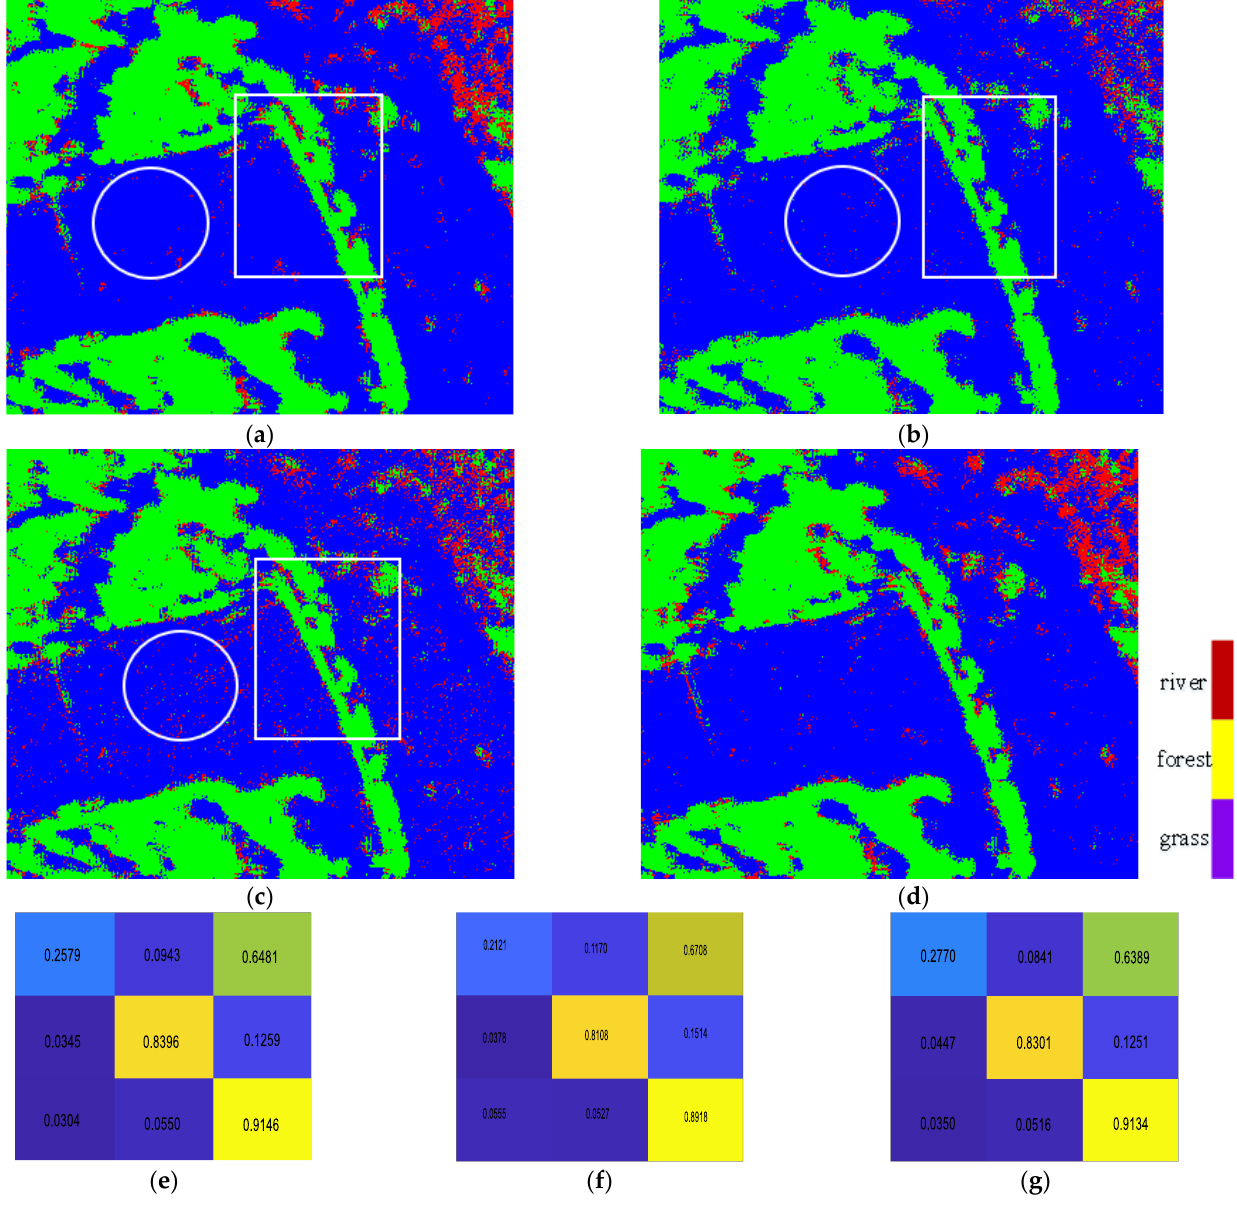
Figure 16. The classification results on TerraSAR image: ( a ) Results of the GCA-CNN; ( b ) Results of the OI-CNN; ( c ) Results of the SI-CNN; ( d ) Results of the GHFM-CNN. ( e – g ) The confusion matrices of the GCA-CNN, OI-CNN and the GHFM-CNN of TerraSAR image (For better visualization).